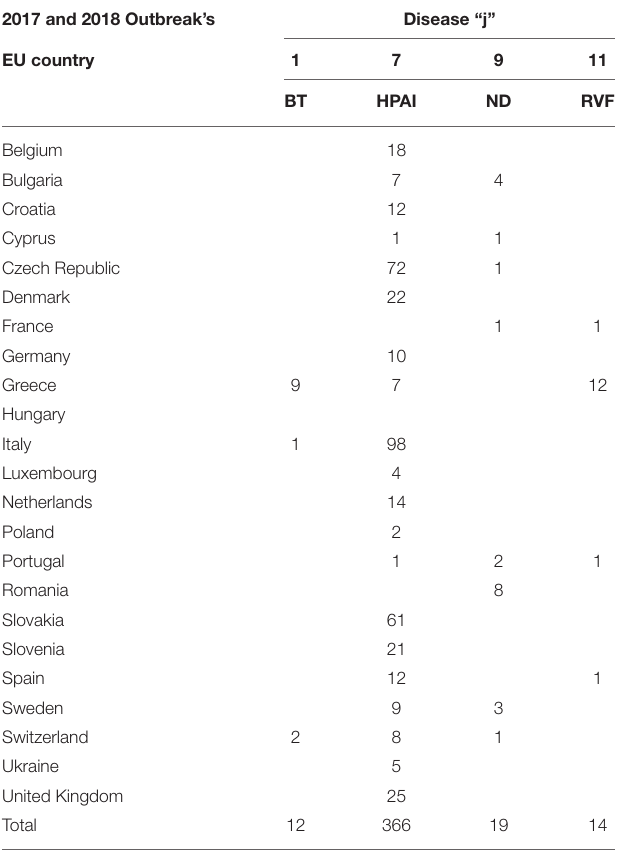
TABLE 11 | Diseases outbreaks in the European countries during the years: 2017 and 2018 (OIE World Animal Health Information